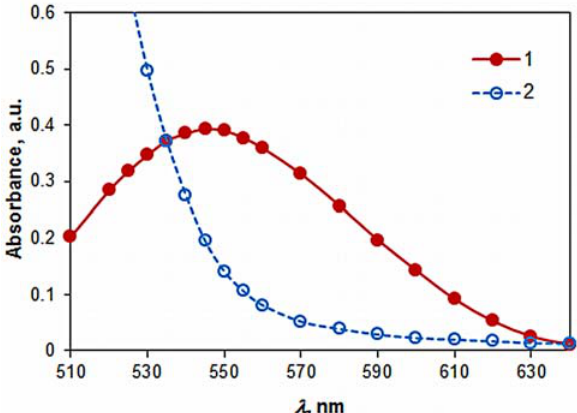
Figure 1. Absorption spectra of the ternary complex (curve 1) and blank (curve 2) in chloroform. c × 10 –4 mol dm –3 , c